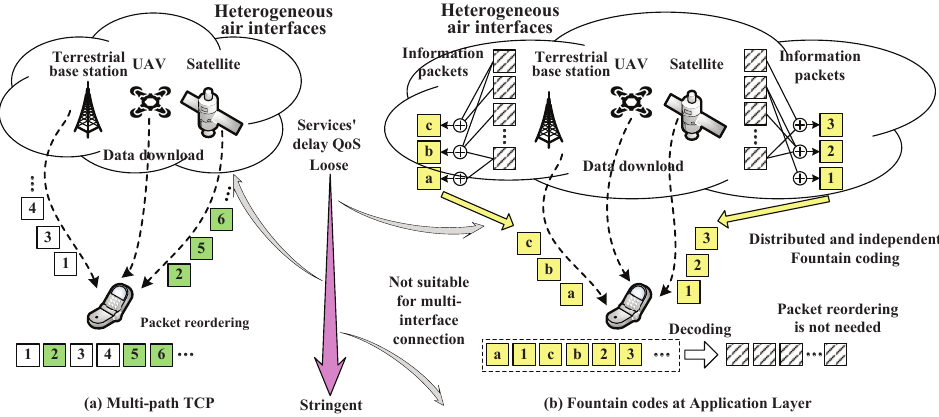
Figure 8. Service-aware access of heterogeneous RATs: the multi-path TCP approach and fountain- code-based